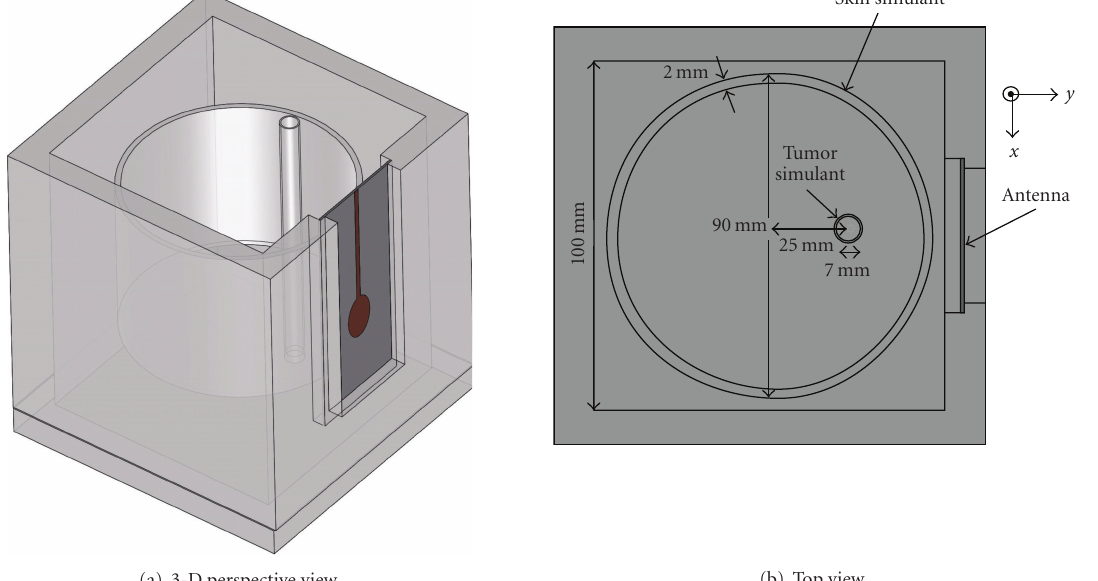
Figure 3: Schematics of experimental/numerical